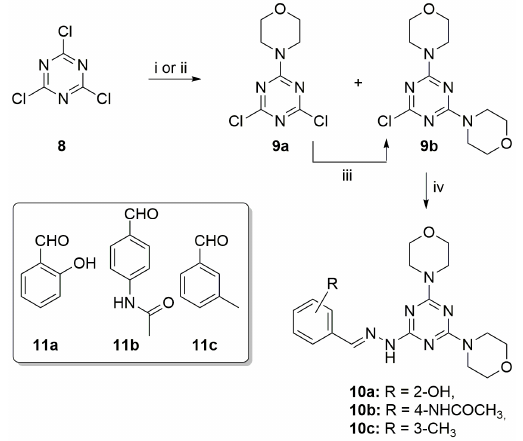
Scheme 1. Synthesis of triazine derivatives 10a–c . Reagents and conditions: (i) DME, −60 °C, mor-